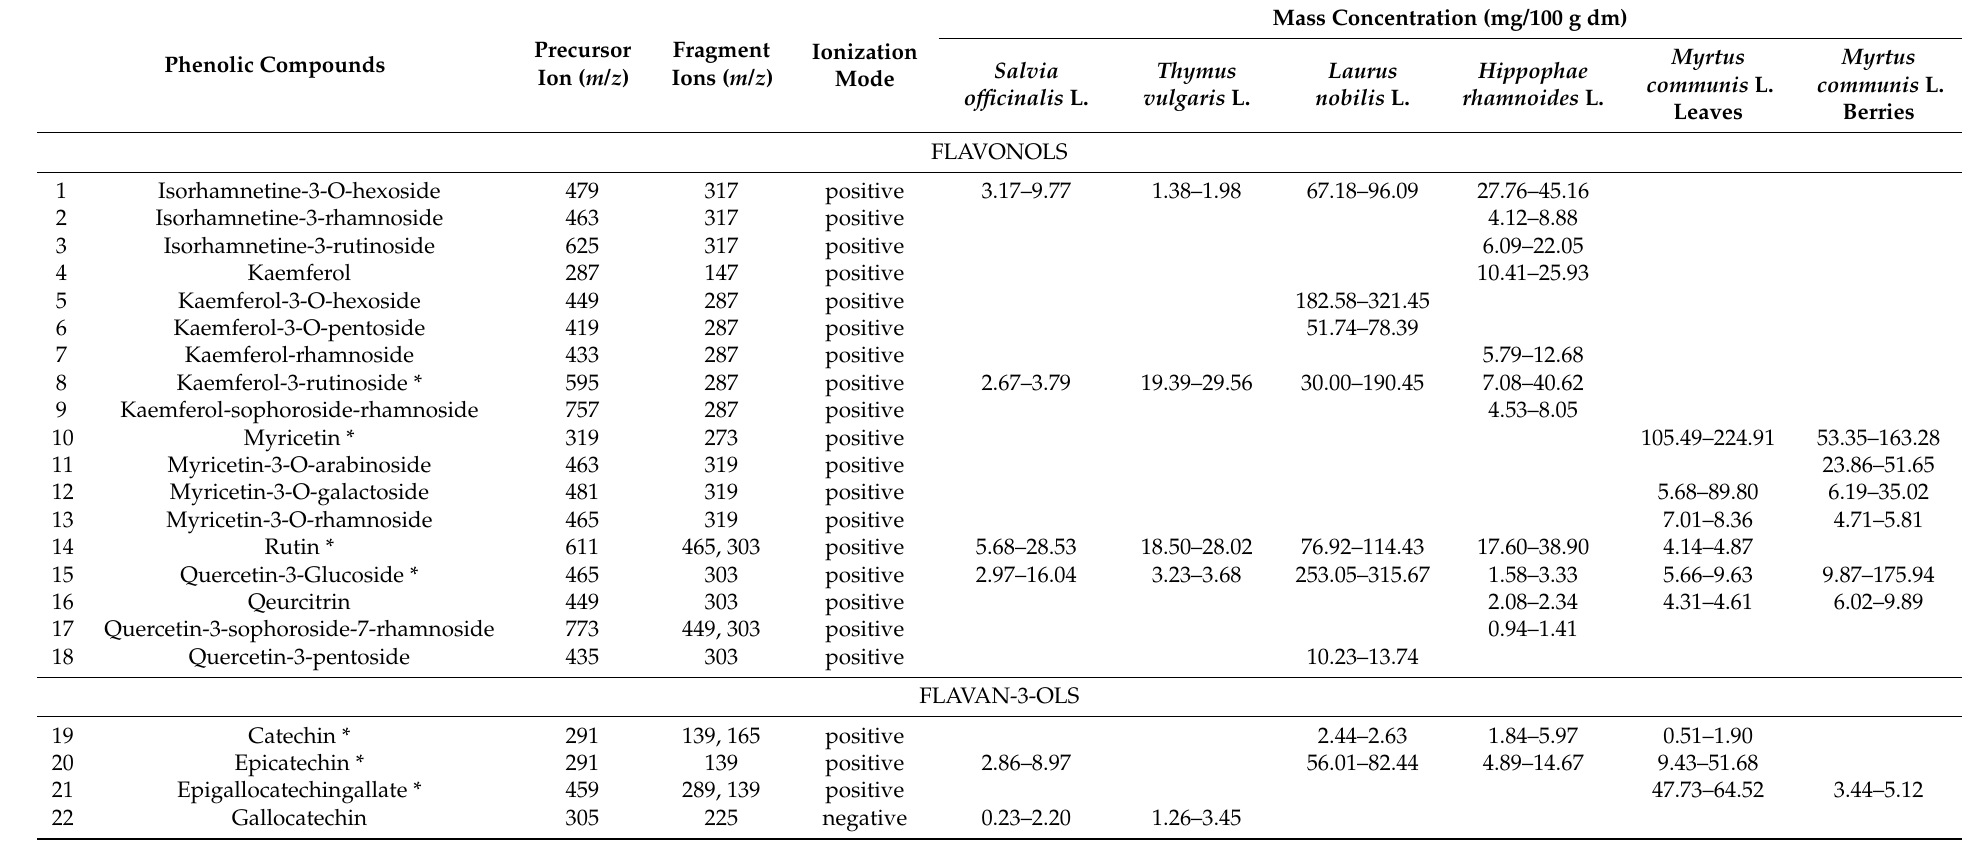
Table 1. Mass spectrometric data, identification and mass concentration range of polyphenols determined in bay ( Laurus nobilis L.) leaves, sage ( Salvia officinalis L.) leaves, thyme ( Thymus vulgaris L.) leaves, myrtle ( Myrtus communis L.) leaves and berries and sea buckthorn ( Hippophae rhamnoides L.)